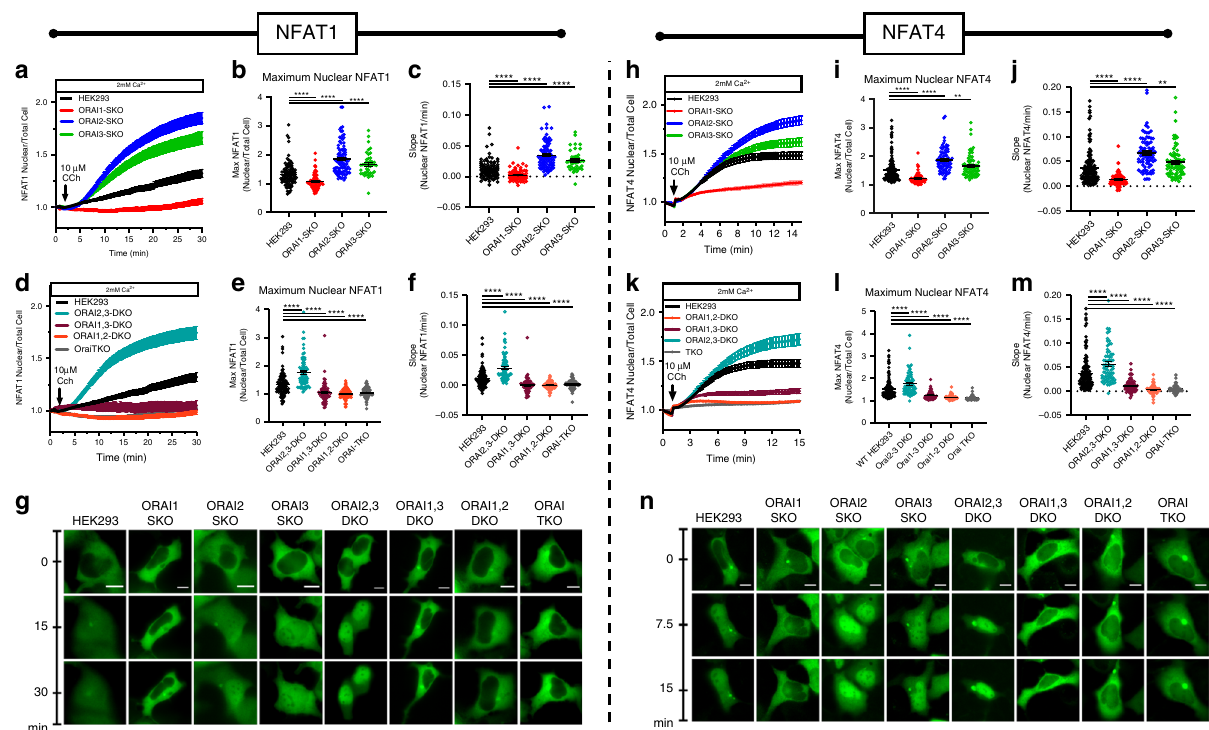
Fig. 7 ORAI2 and ORAI3 ensure differential activation of NFAT isoforms. a , d Time-lapse quanti fi cation represented as mean ± SEM of nuclear translocation in response to 10 µ M Cch stimulation in the presence of 2 mM Ca 2 + of NFAT1-GFP transfected either in parental HEK293 cells or ORAI single- ( a ), double- ( d ), or triple- ( d ) knockout cells; images were captured every 10 s. b , e Maximal NFAT1-GFP nuclear translocation determined by the ratio of nuclear/total cell GFP fl uorescence. c , f Rate of NFAT1-GFP nuclear translocation in response to Cch stimulation. g Representative images of different cell types transfected with NFAT1-GFP at time 0 and 15 min and 30 min after stimulation with 10 µ M Cch. Scale bar: 10 µ m (for all NFAT1 experiments n = 98(HEK293), n = 84(ORAI1-SKO), n = 93(ORAI2-SKO), n = 44(ORAI3-SKO), n = 79(ORAI1,2-DKO), n = 65(ORAI1,3-DKO), n = 76 (ORAI2,3-DKO), n = 64(ORAI-TKO); all points are single cells). h , k Time-lapse quanti fi cation represented as mean ± SEM of nuclear translocation in response to 10 µ M Cch stimulation in the presence of 2 mM Ca 2 + of NFAT4-GFP transfected either in parental HEK293 cells or ORAI single- ( h ), double- ( k ), or triple- ( k ) knockout cells; images were captured every 10 s. i , l Maximal NFAT4-GFP nuclear translocation determined by the ratio of nuclear/total cell GFP fl uorescence. j , m Rate of NFAT4-GFP nuclear translocation in response to Cch stimulation. n Representative images of different cell types transfected with NFAT4-GFP at time 0, and 15 min and 30 min after stimulation with 10 µ M Cch. Scale bar: 10 µ m (for all NFAT4 experiments n = 130 (HEK293), n = 72(ORAI1-SKO), n = 82(ORAI2-SKO), n = 79(ORAI3-SKO), n = 90(ORAI1,2-DKO), n = 59(ORAI1,3-DKO), n = 71(ORAI2,3-DKO), n = 59 (ORAI-TKO); all points are single cells). Scatter plots are represented as mean ± SEM. All data in Fig. 7 was analyzed using the Kruskal – Wallis one-way ANOVA with multiple comparisons and was derived from a minimum of three independent experiments. (* p < 0.05; ** p < 0.01; *** p < 0.001; **** p <